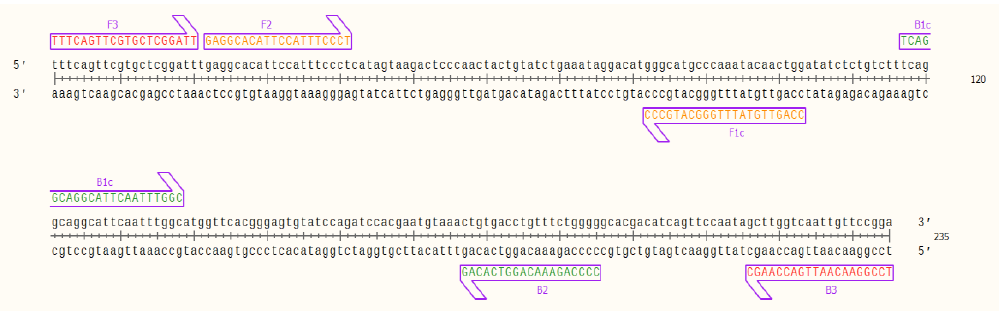
Figure 1. Nucleic acid sequence of the target OsHV-1 DNA fragment (235 bp) and designed LAMP primers binding sites; outer primers: F3 and B3 (red), inner primers: F2 and F1c (FIP) (orange), and B1c and B2 (BIP) (green) visualized using SnapGene Viewer® 5.0.4.